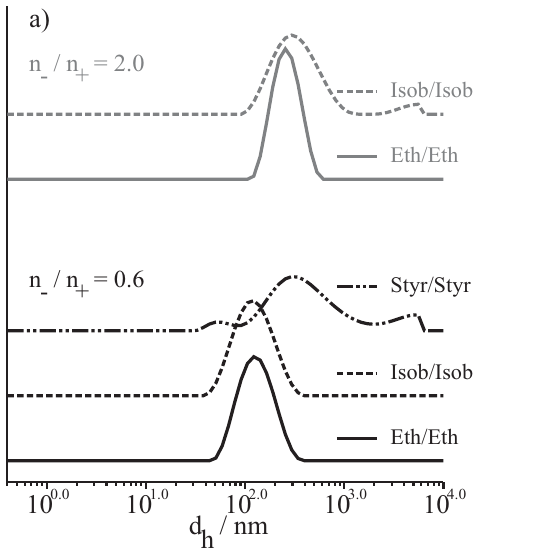
/n ratios, prepared on − +